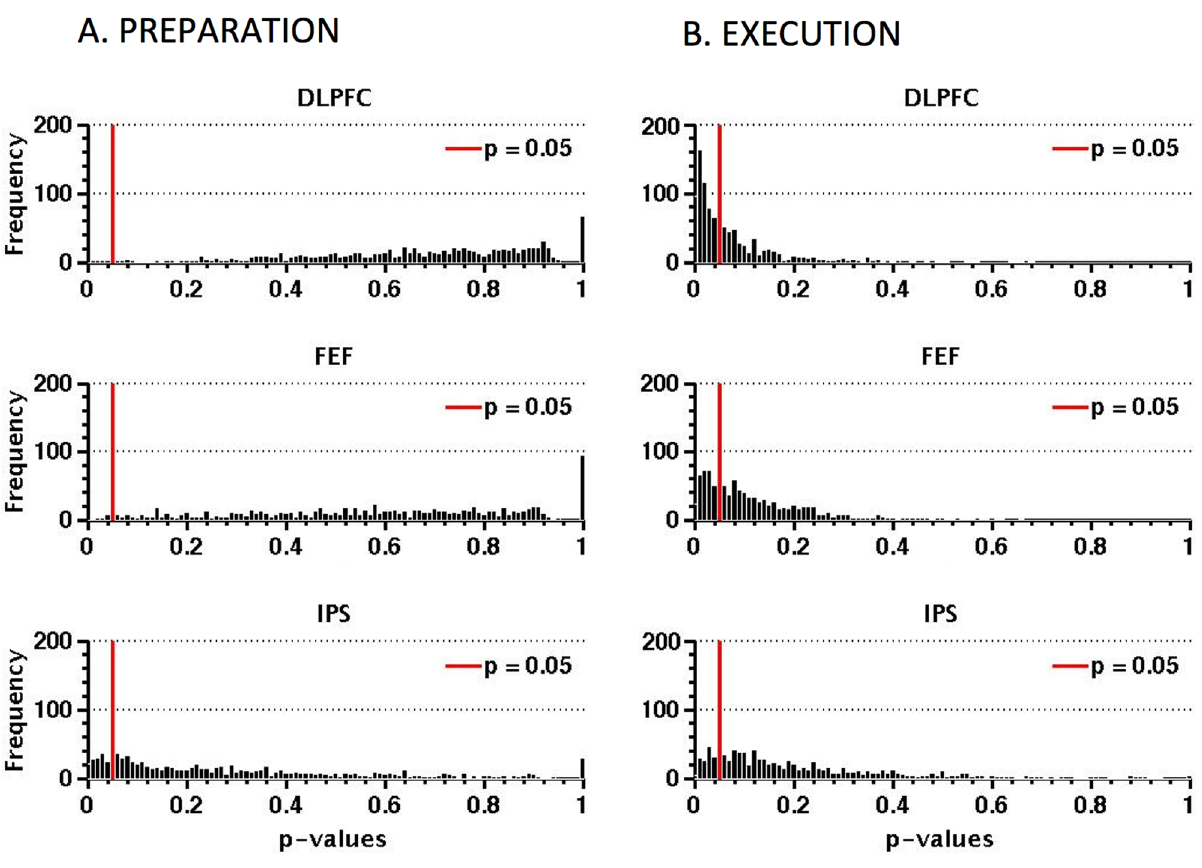
Fig 6. Results from an analysis in which decoding performance during the preparation phase (A) and the execution phase (B) (based on 500 voxels) was compared with the performance in the same sample when the labels (pro-saccade, anti-saccade) associated with the exemplars were randomly permuted. 1000 t-tests were performed with different voxel samples and label permutations. The binned frequency of p-values associated with the t-tests is shown as a function of p-value. Clustering at low values indicates strong sensitivity to saccade